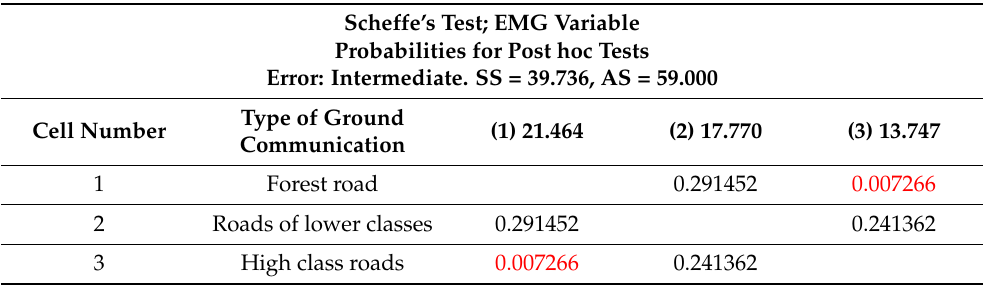
Figure 6. Dispersion analysis of the dependence of muscle load values ( A ) and heart rate ( B ) on the type of communication used when driving the passenger car (author). Table 9. Post hoc test to analyze the variance of muscle load values depending on the type of communication when driving the passenger car. The red text indicates statistical significance.